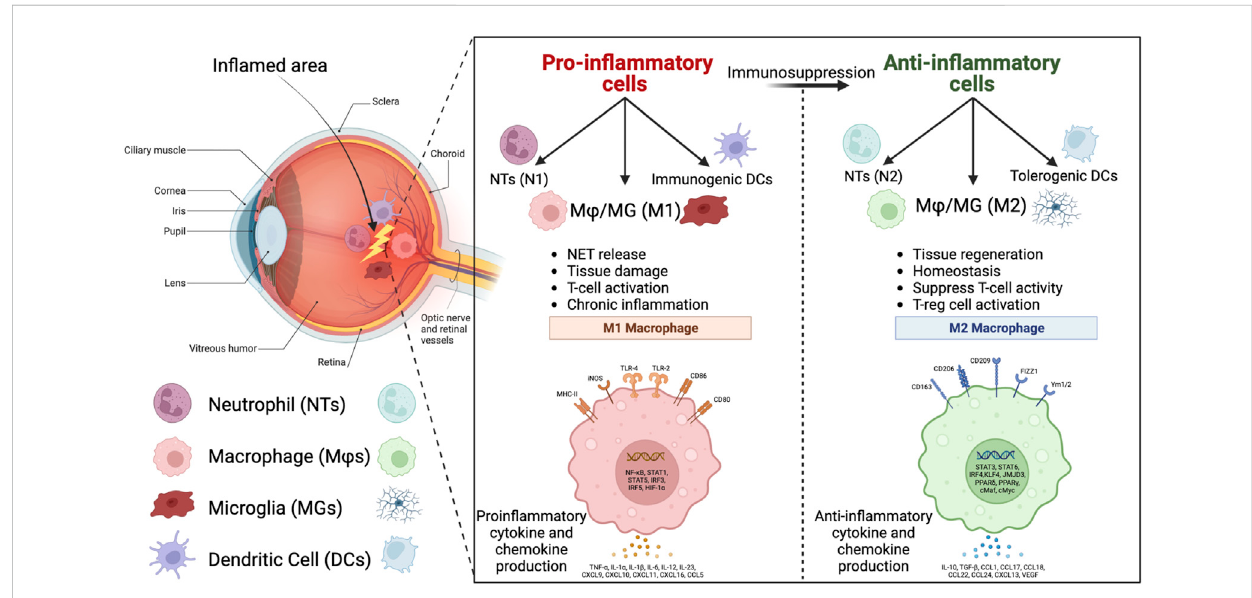
FIGURE 2 Eye tissue and the key innate immune cells in the in fl amed area. The pro-in fl ammatory innate immune cells, including N1 neutrophils (NTs), M1 macrophages/microglia (M Φ /MG), and immunogenic dendritic cells (DCs), with proin fl ammatory functions that are listed in the left window, can be re-educatedbyimmunomodulatorybiomaterialstoanti-in fl ammatorycells, includingN2NTs,M2M Φ /MG,andtolerogenicDCs,withanti-in fl ammatory functions that are listed in the right window (Created in